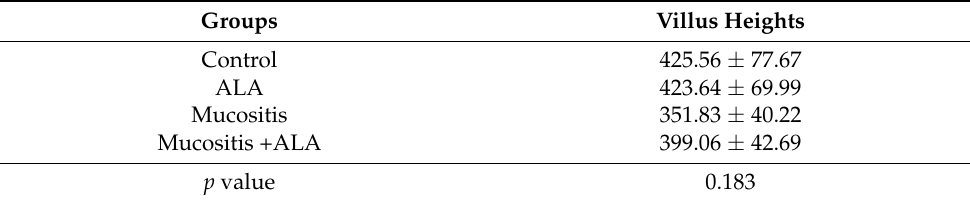
Figure 3. Histological view of HE stained stomach tissue for ( a ) the Control group, ( b ) the ALA group, ( c ) the Mucositis group, and ( d ) the Mucositis + ALA group. Bar = 100 μ m; enlarged area Bar = 50 μ m. ( a ) It is seen that epithelial cells and gland structures of the corpus-fundus region of the stomach of the control group are normal. ( b ) The stomach structure of the ALA-only group is similar to the control group. ( c ) Degeneration of gastric epithelial cells and edema (*) and enlargement of glands (arrows) are common in the Mucositis group. ( d ) It is seen that edema in the surface epithelial cells and enlargement of the glands decreased in the Mucositis + ALA group compared to the Mu- cositis group. In both the control and experimental groups, no structural alterations in the large intestine were seen. Visually normal simple layered columnar epithelial cells, goblet cells, and glands were observed (Figure 5a–d). Table 3. Histomorphological scoring of small intestine villus heights ( μ m).